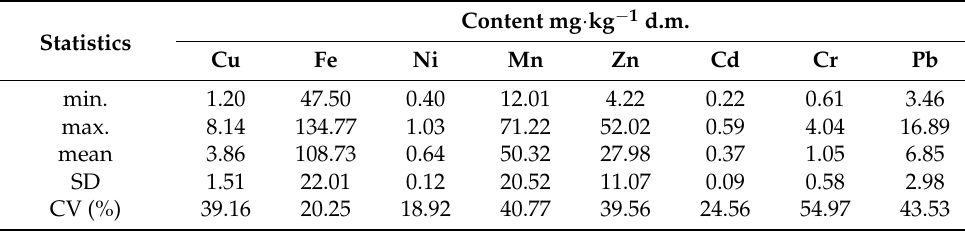
Table 7. The content of heavy metal in soils of 31 allotment plots in Gorz ó w Wielkopolski.